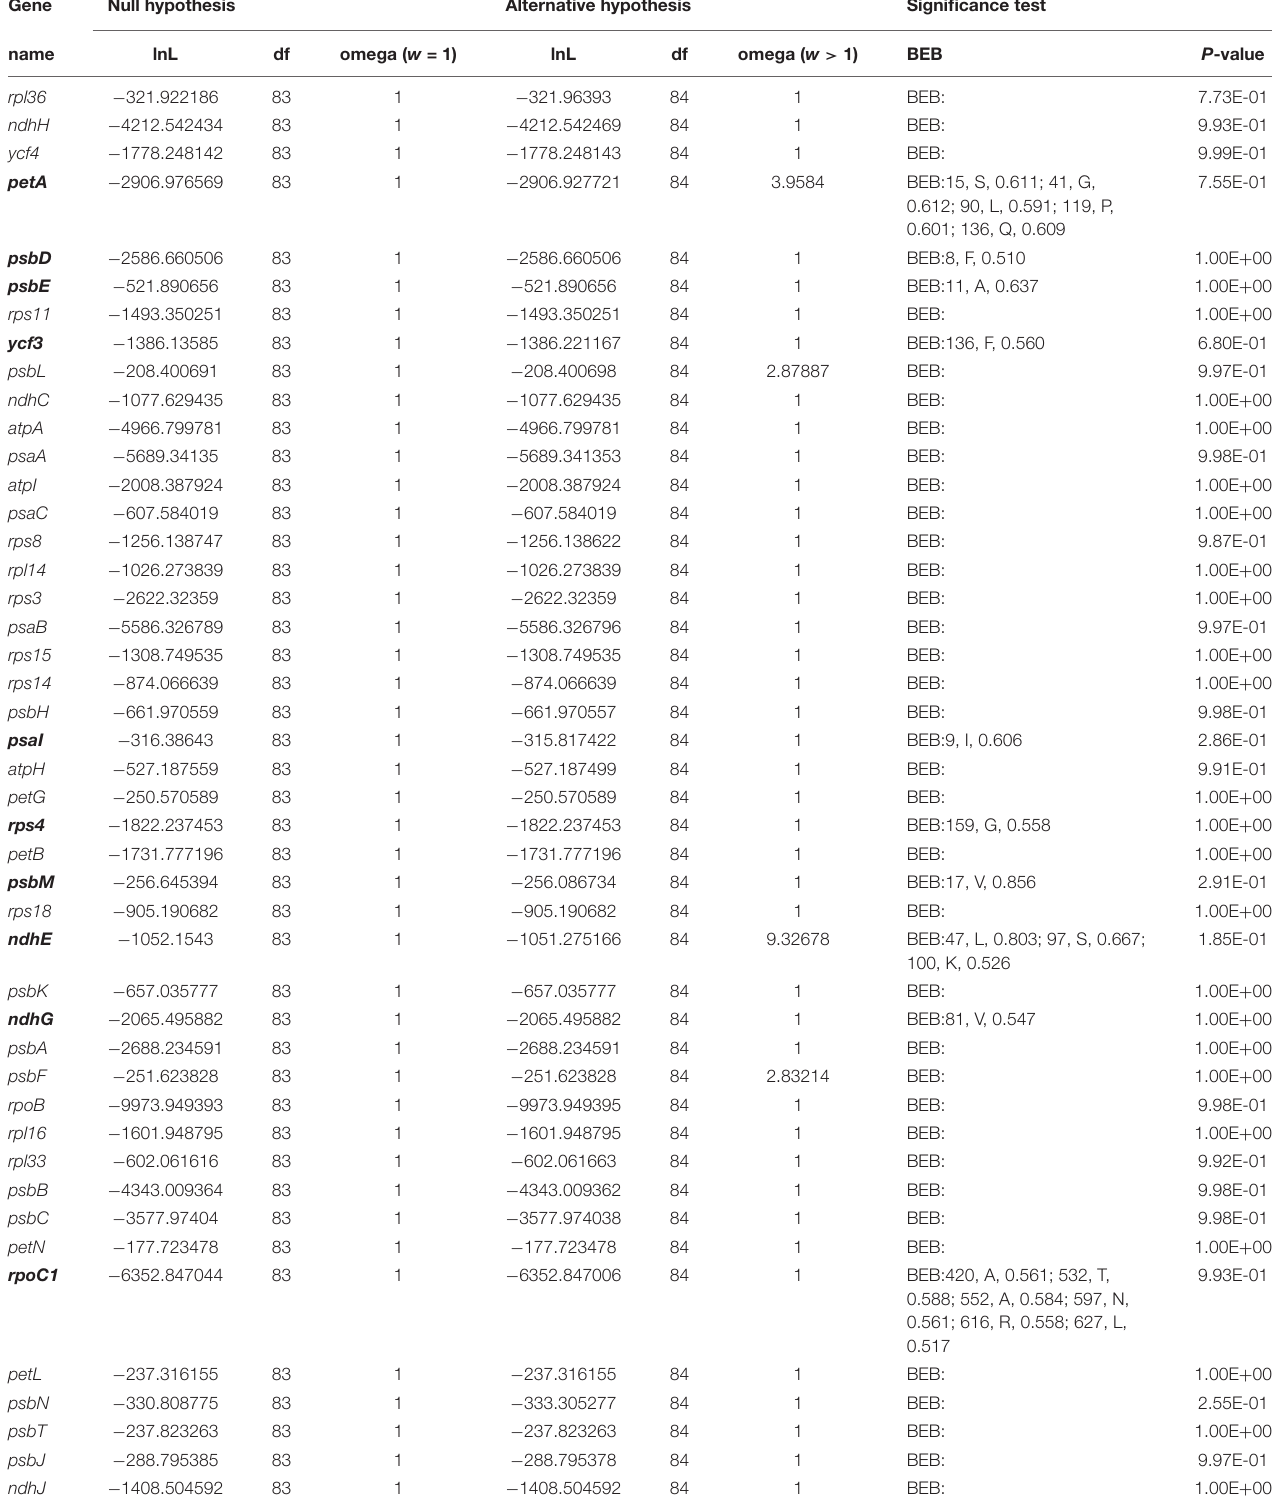
Bold types are genes with positively selected sites. BEB, Bayesian Empirical